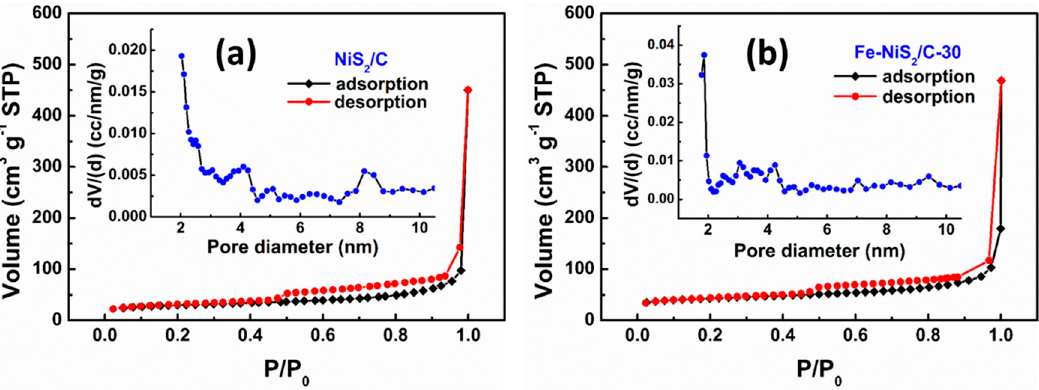
Figure 4. N 2 adsorption-desorption isotherms for ( a ) NiS 2 / C, and ( b ) Fe-NiS 2 / C-30. Inset in each panel is the corresponding pore diameter distribution plot.